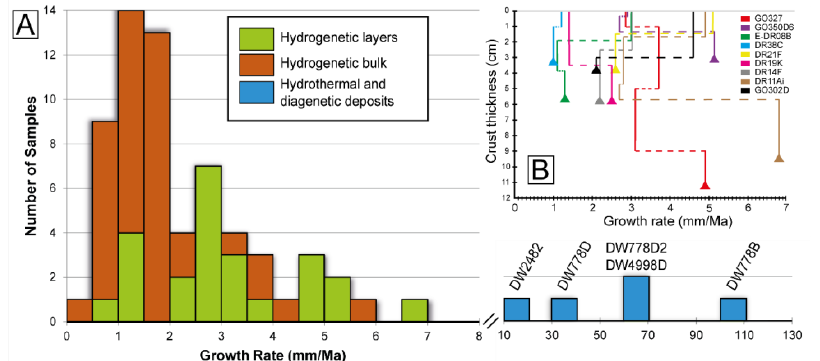
Figure 8. ( A ) Histogram of growth rates of New Caledonia ’ s EEZ crusts samples using [66] equation; ( B ) Graph of the growth rate variation versus crust thickness of the samples with one or more sub-samples ( n = 9).